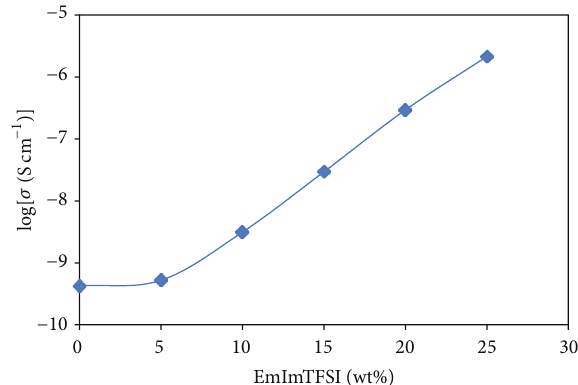
Figure 1: The variation of ionic conductivity with different wt% of EMImTFSI at room